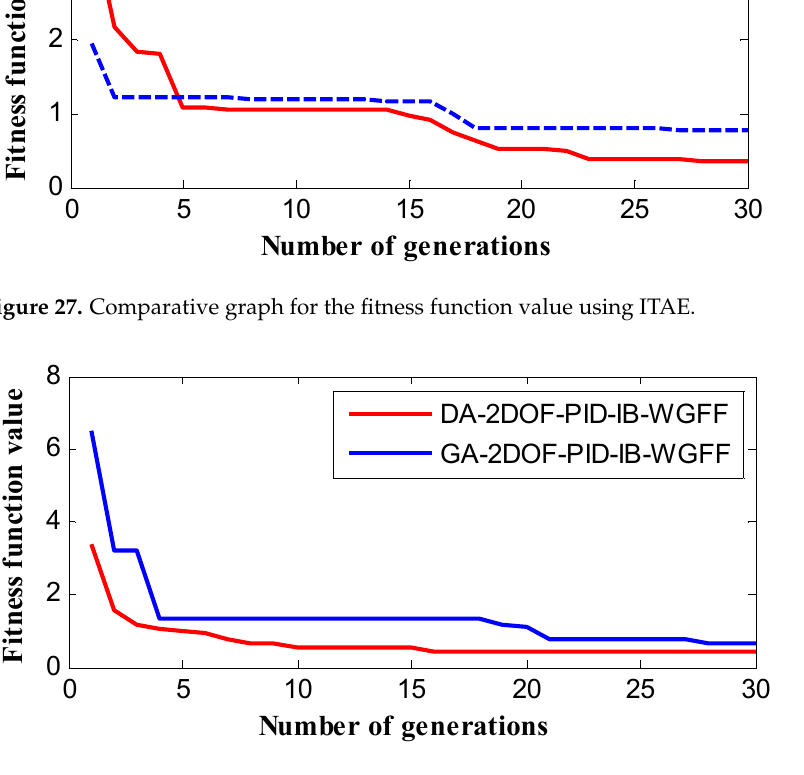
Figure 28. Comparative graph for the fitness function value using proposed IB-WGFF.